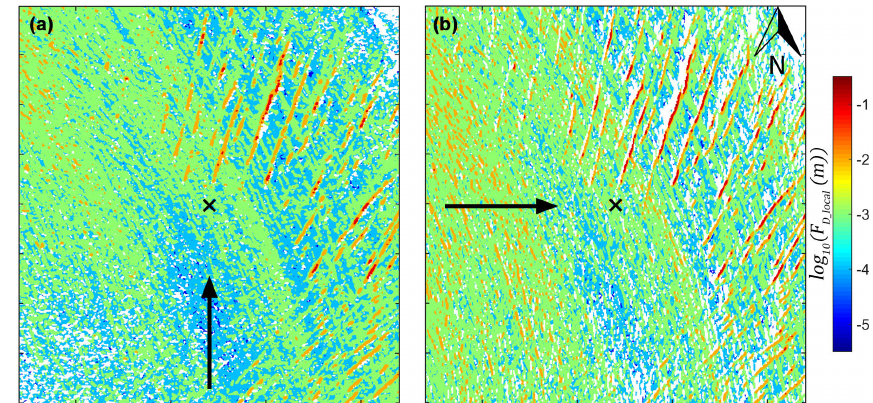
Figure 15. Comparison of the F D_local values from the block method for (a) southerly (downslope) and (b) westerly (cross-slope) wind direction at CG16-1 in September 2016. Airflow (black arrow) and AWS location (black cross) are also